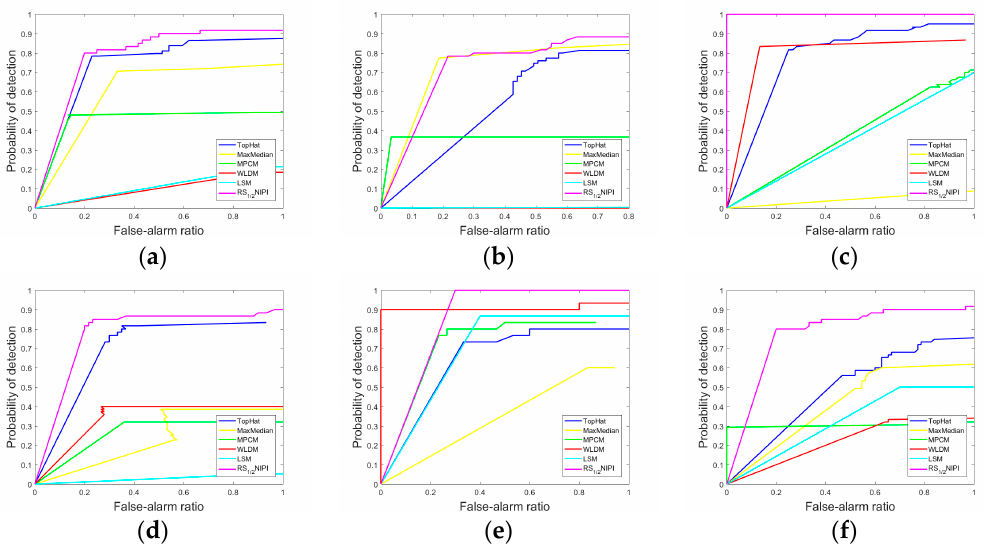
Figure 13. The ROC curves of detection results obtained using different methods ( a ) Sequence 1. ( b ) Sequence 2. ( c ) Sequence 3. ( d ) Sequence 4. ( e ) Sequence 5. ( f ) Sequence 6. Table 5. Quantitative indicators of the different methods in term of G LSNR , G SCR and BSF. Methods